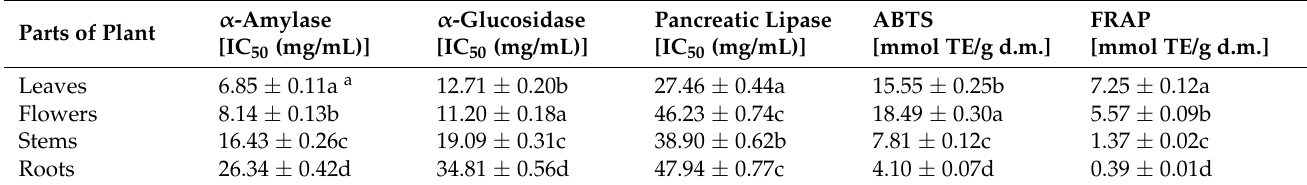
Table 3. In vitro biological